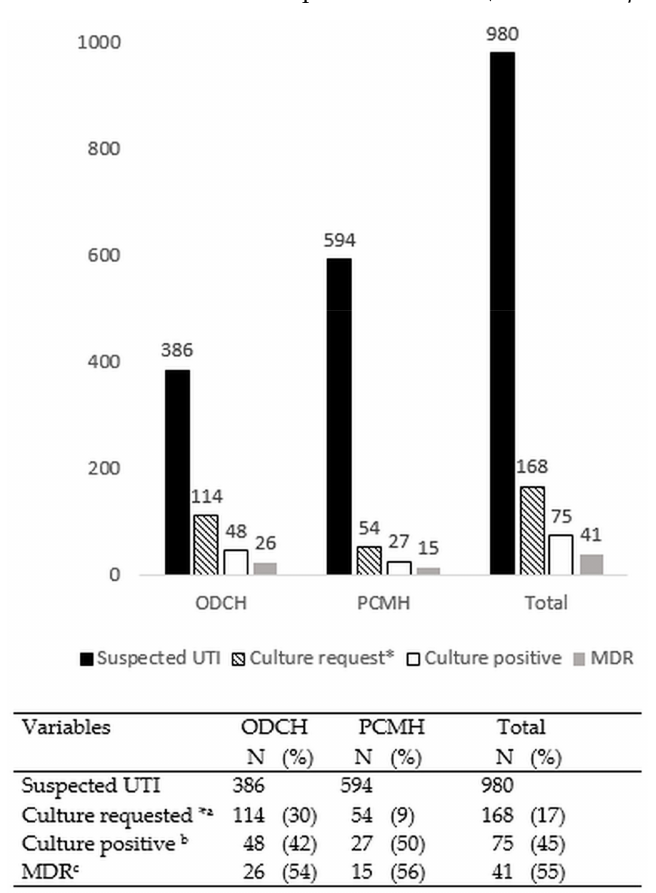
Figure 1. Numbers of patients with suspected urinary tract infections, culture requests, and those processed through to positive cultures in the two hospitals in Freetown, Sierra Leone, between May 2017 and May 2021. UTI—urinary tract infection; MDR—multidrug resistant; * all culture requests underwent urine culture; a denominator is suspected UTI; b denominator is culture requested; c denominator is culture